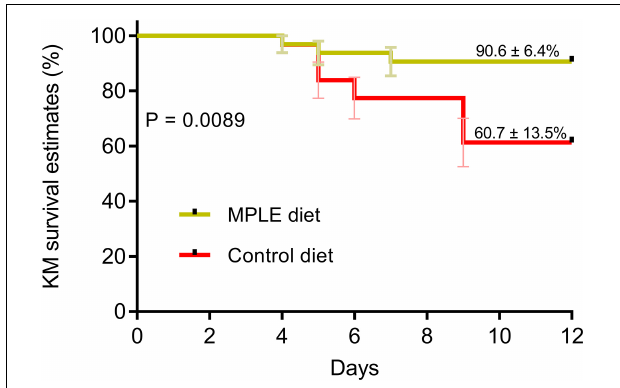
FIGURE 4 | Results of the bacterial challenge conducted in Atlantic salmon smolts intraperitoneally injected with 10 7 CFU mL − 1 of A . salmonicida . Kaplan-Meier (KM) survival curves (%) for Atlantic salmon smolts intraperitoneally injected with A . salmonicida subsp. salmonicida (10 7 CFU mL − 1 ) during the 12 days challenge trial period. Data correspond to the mean ± standard error (4 replicates tanks per experimental diet; n = 8 fish per